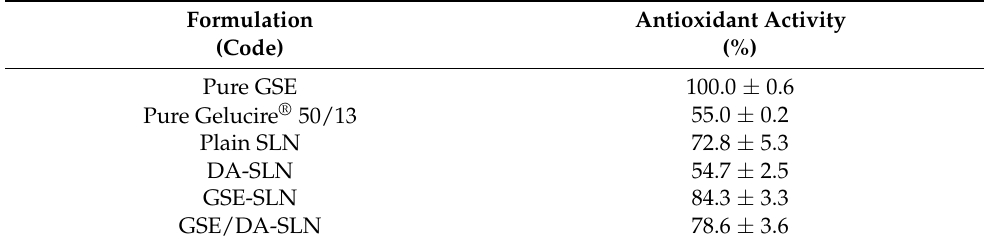
Table 2. Antioxidant Activity of Some Starting Materials and SLN.